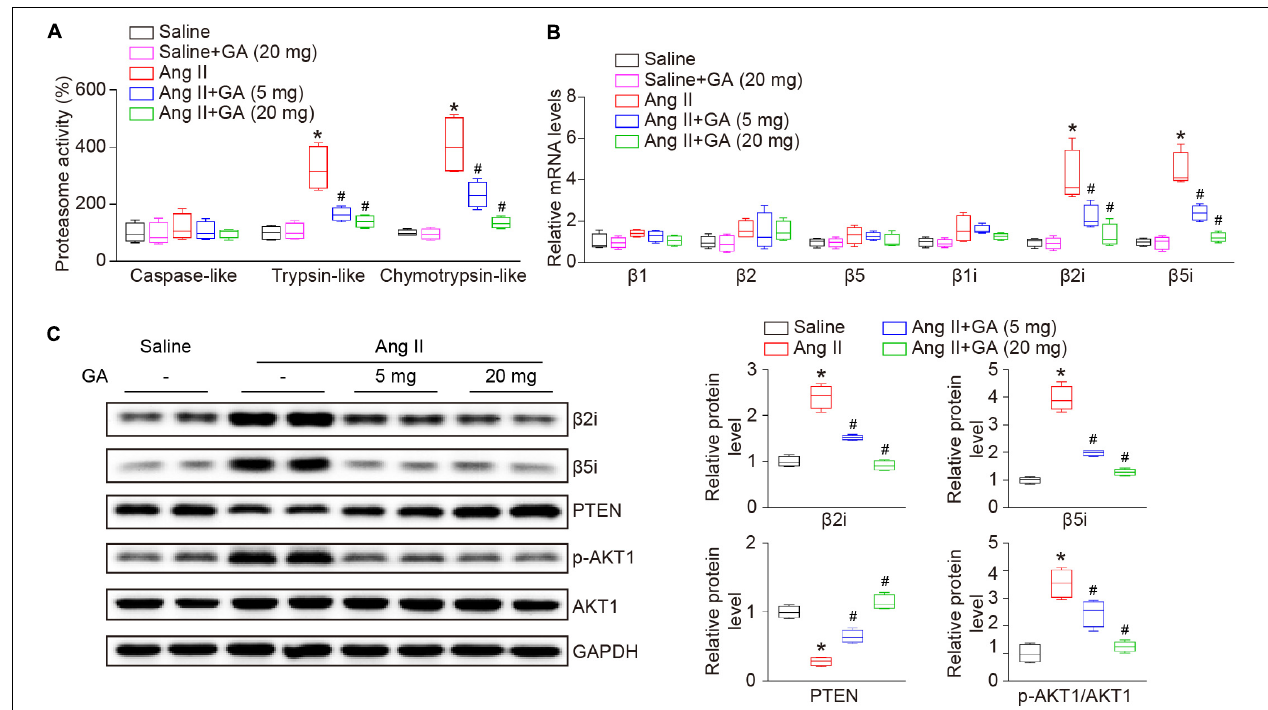
FIGURE 4 | GA reduces the activity and expression of immunoproteasome subunits β 2i and β 5i and PTEN degradation in the atria after Ang II infusion. (A) The proteasome activities in the atria after Ang II infusion in the presence or absence of GA treatment ( n = 4). (B) qPCR analyses of the mRNA expression levels of β 1, β 2, β 5, β 1i, β 2i, and β 5i ( n = 4). (C) Representative immunoblotting analyses of the protein expression levels of β 2i, β 5i, PTEN, p-AKT1, and AKT1 (left), and quantification of the relative protein levels (right, n = 4). GAPDH as an internal control. * P < 0.05 versus saline, # P < 0.05 versus Ang